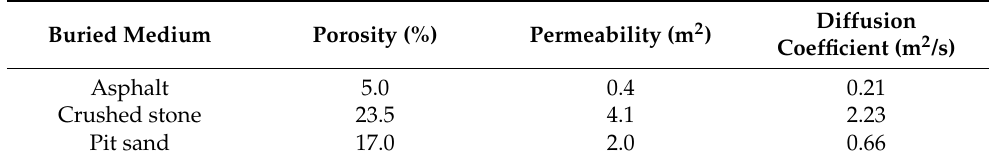
Diffusion Coefficient (m 2 /s)